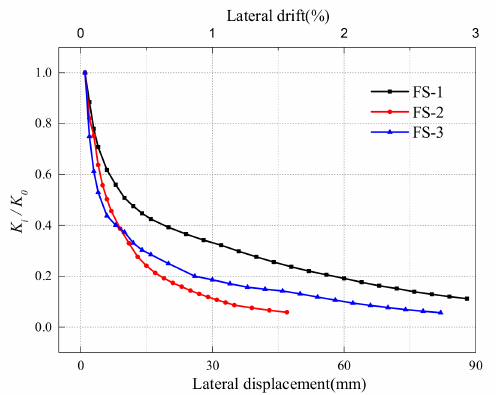
Figure 12. Stiffness degradation ratio